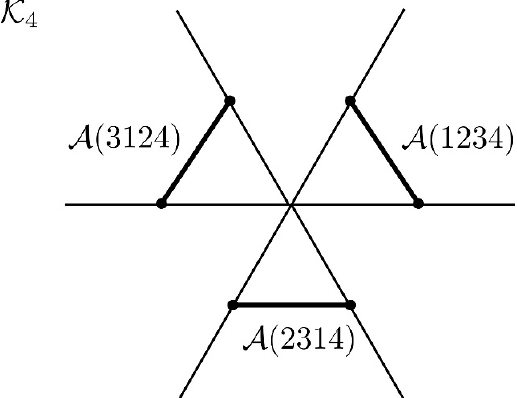
Figure 4 . The three realisations A ( (cid:11) ) of the associahedron in the kinematic space K 4 for four